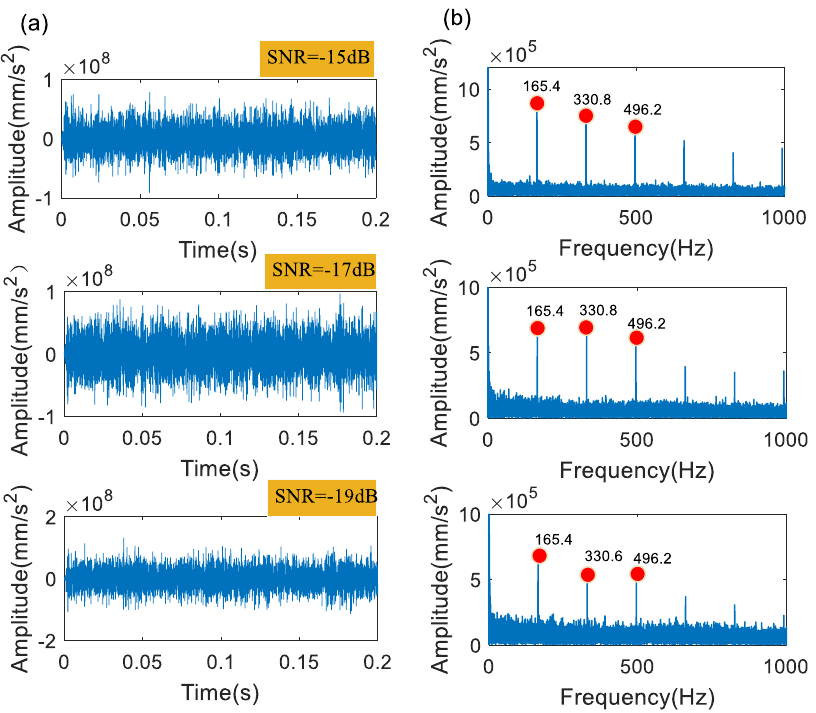
Figure 16. Results of FEM-based wavelet of outer ring fault at different SNRs: ( a ) filtered signal; ( b ) the envelope spectrum of the corresponding filtered signal.